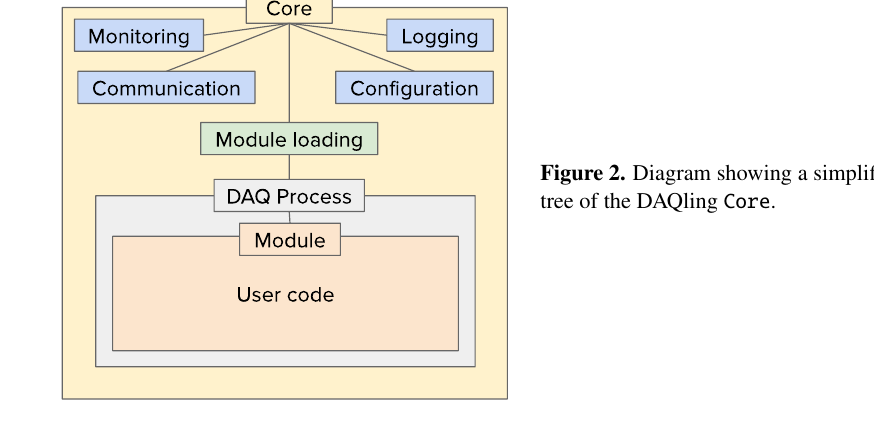
Figure 2. Diagram showing a simplified include tree of the DAQling Core